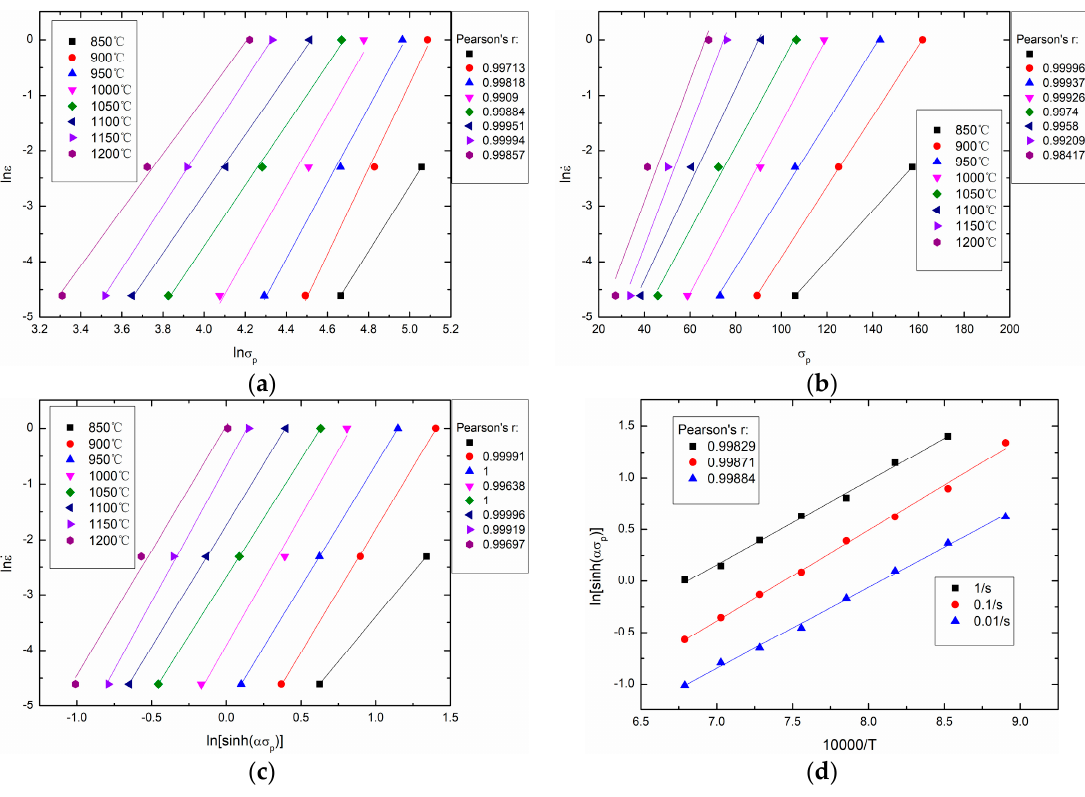
Figure 6. Calculation of material constants: ( a ) n 1 ; ( b ) β ; ( c ) n ; ( d ) Q and A .